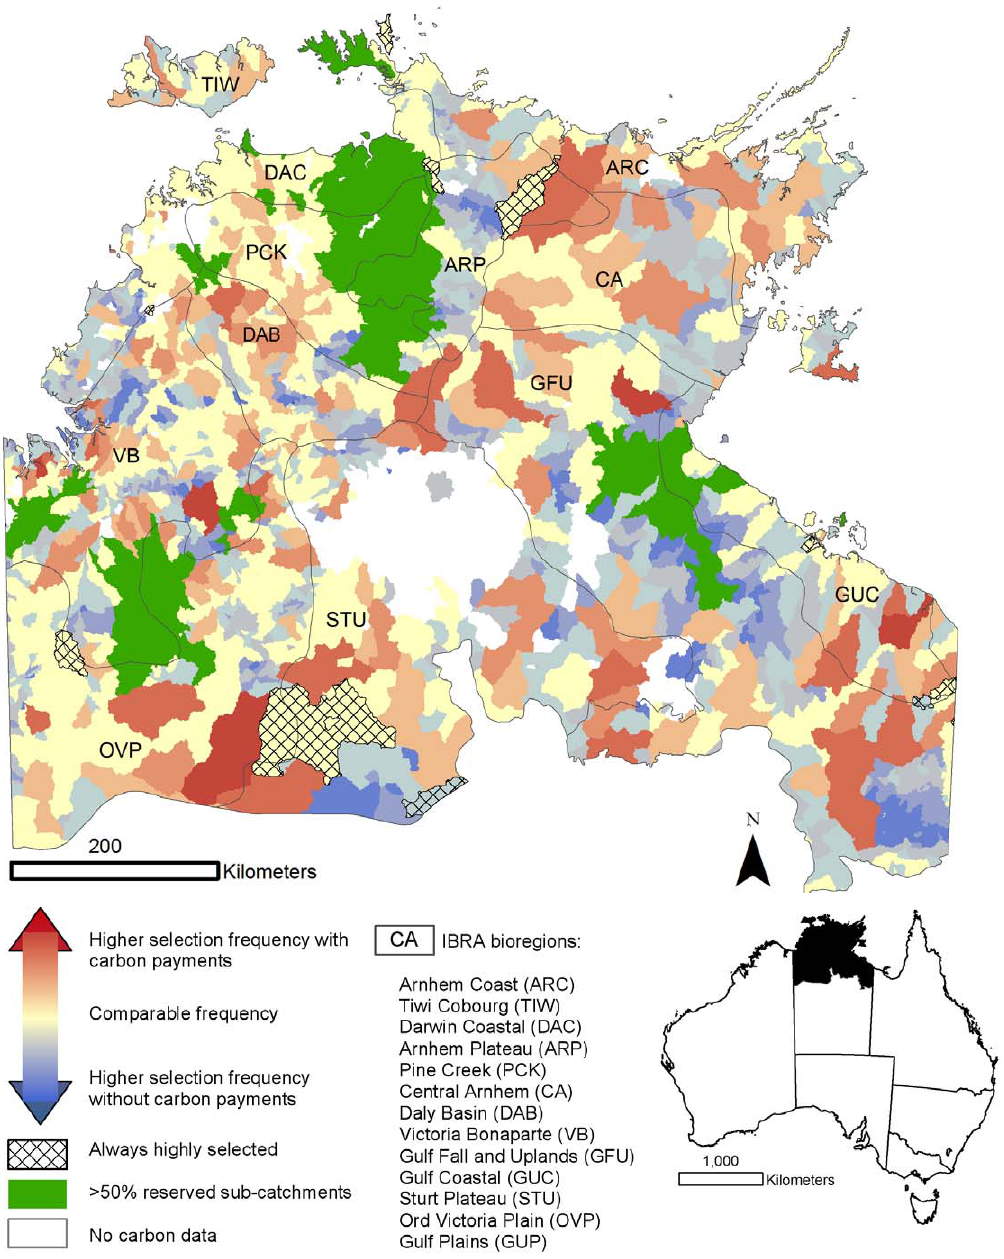
Figure 3. A comparison of the difference in selection frequency, a measure of investment priority, between scenarios 1 and 2.